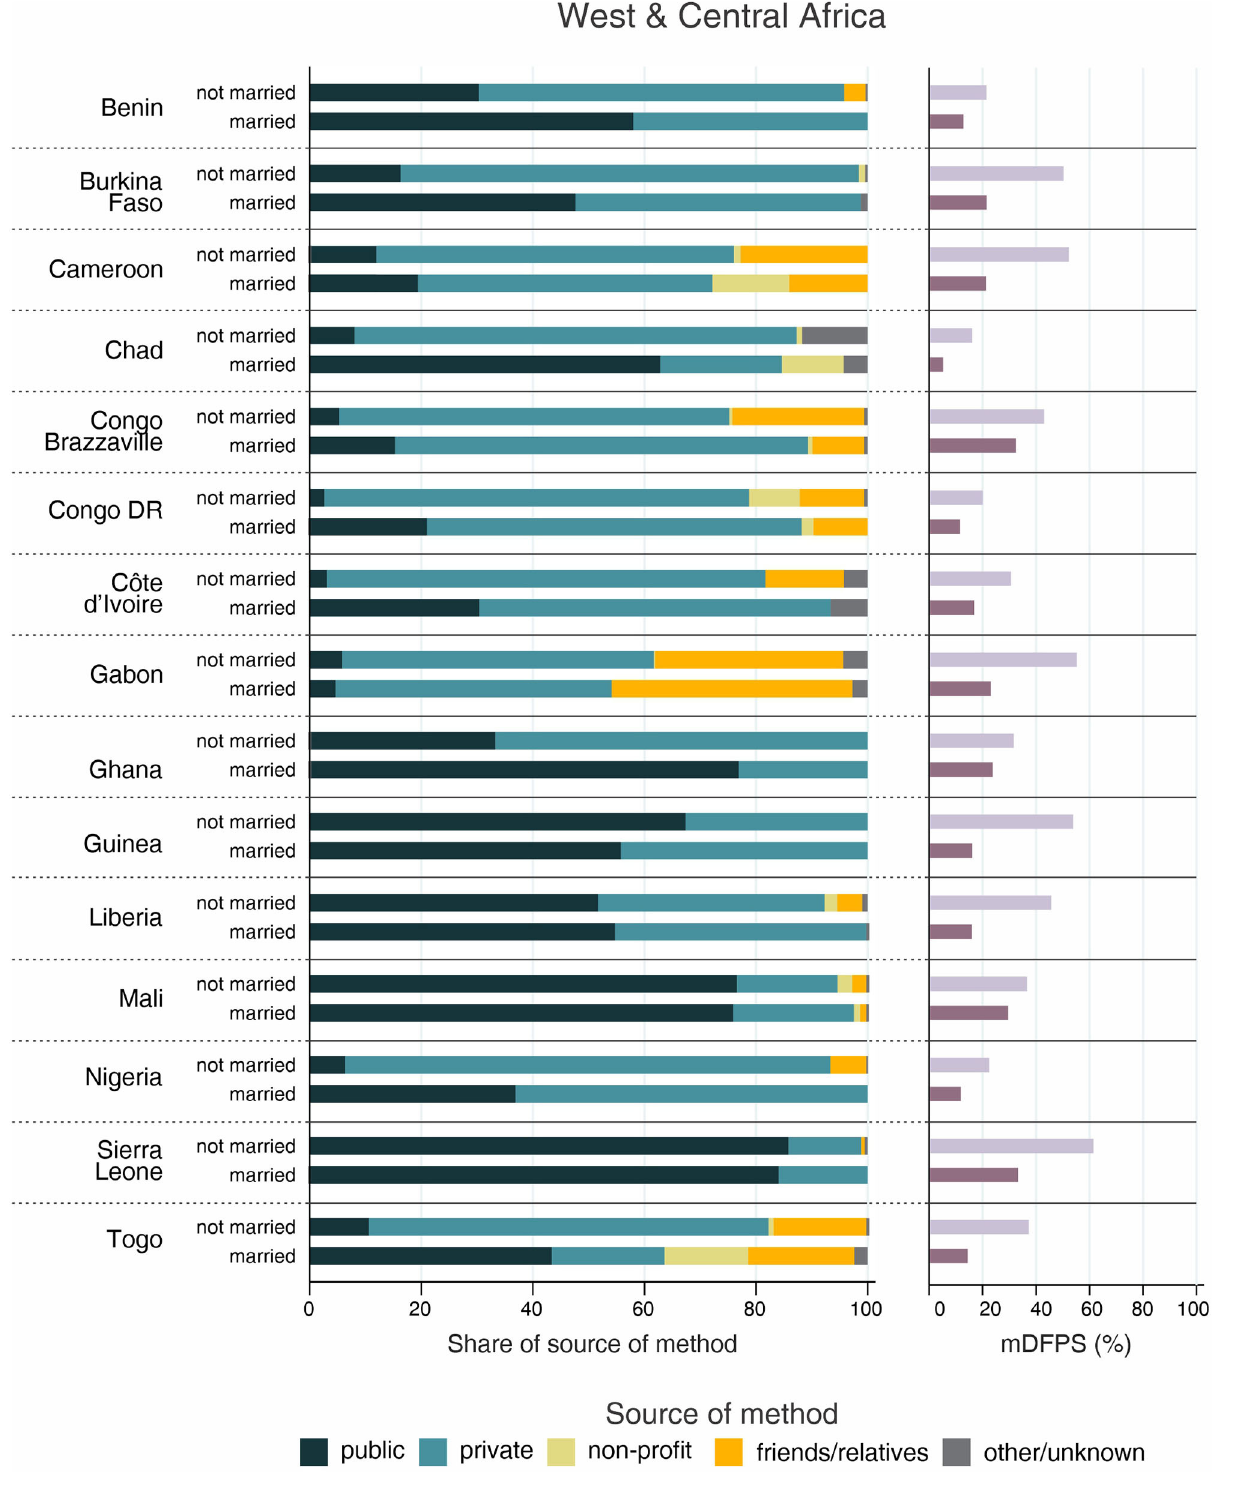
Looking at the country-level estimates, we were also able to identify important differences between countries. The